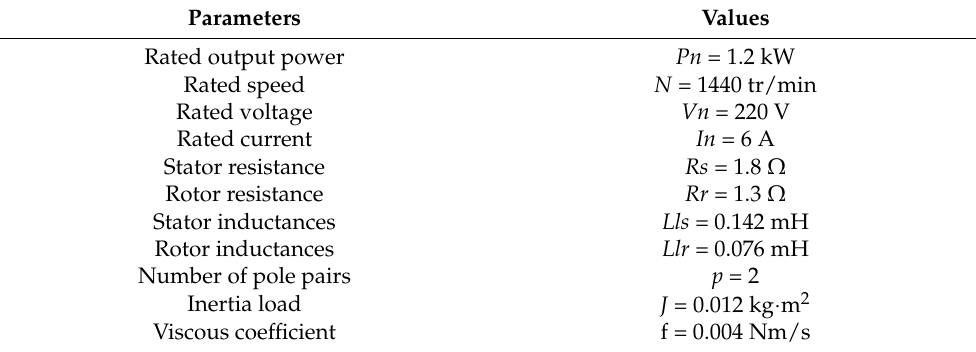
Table 1. The parameters of the IM machine.